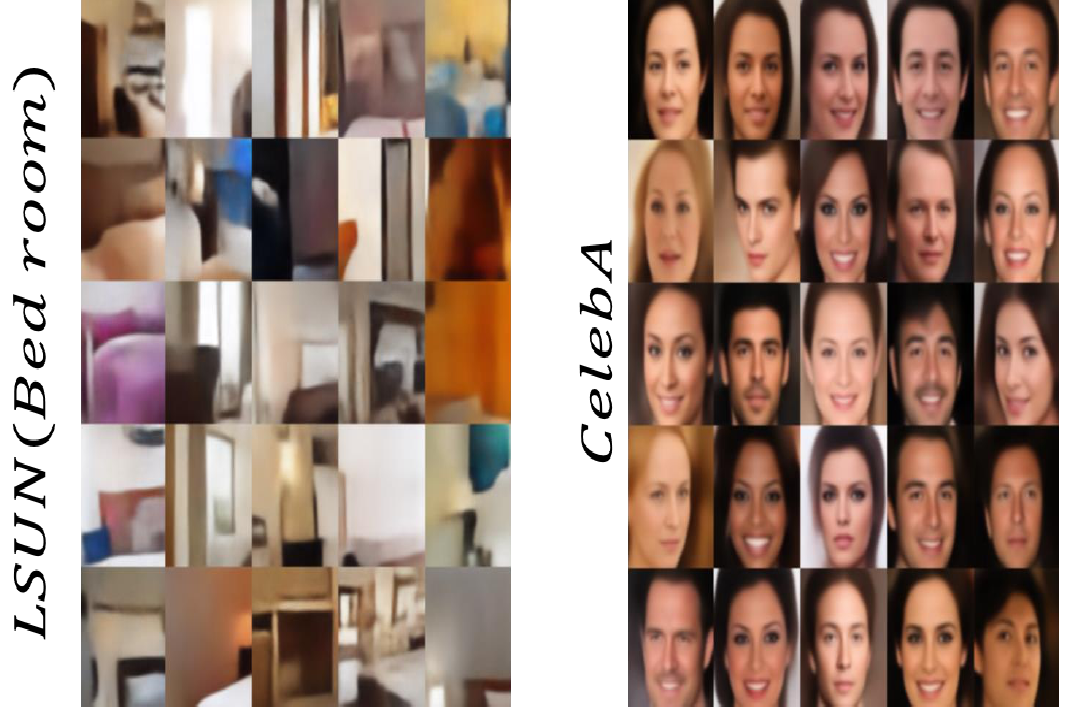
Figure A2. Image generation result of LSUN bedroom and CelebA datasets at 100 epoch.